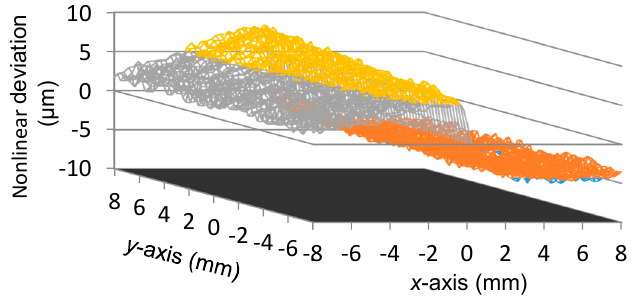
Figure 7. Nonlinear deviations of U x .